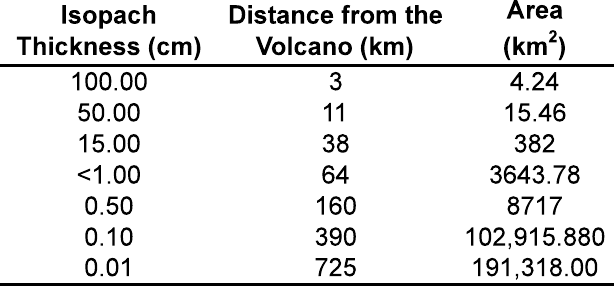
Table 4. Depth ranges of the ash-fall of the 1913 Plinian